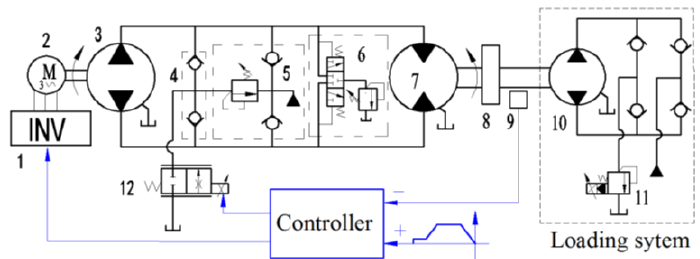
Figure 1. Schematic framework of LVPC (leaking valve-pump parallel control) system.